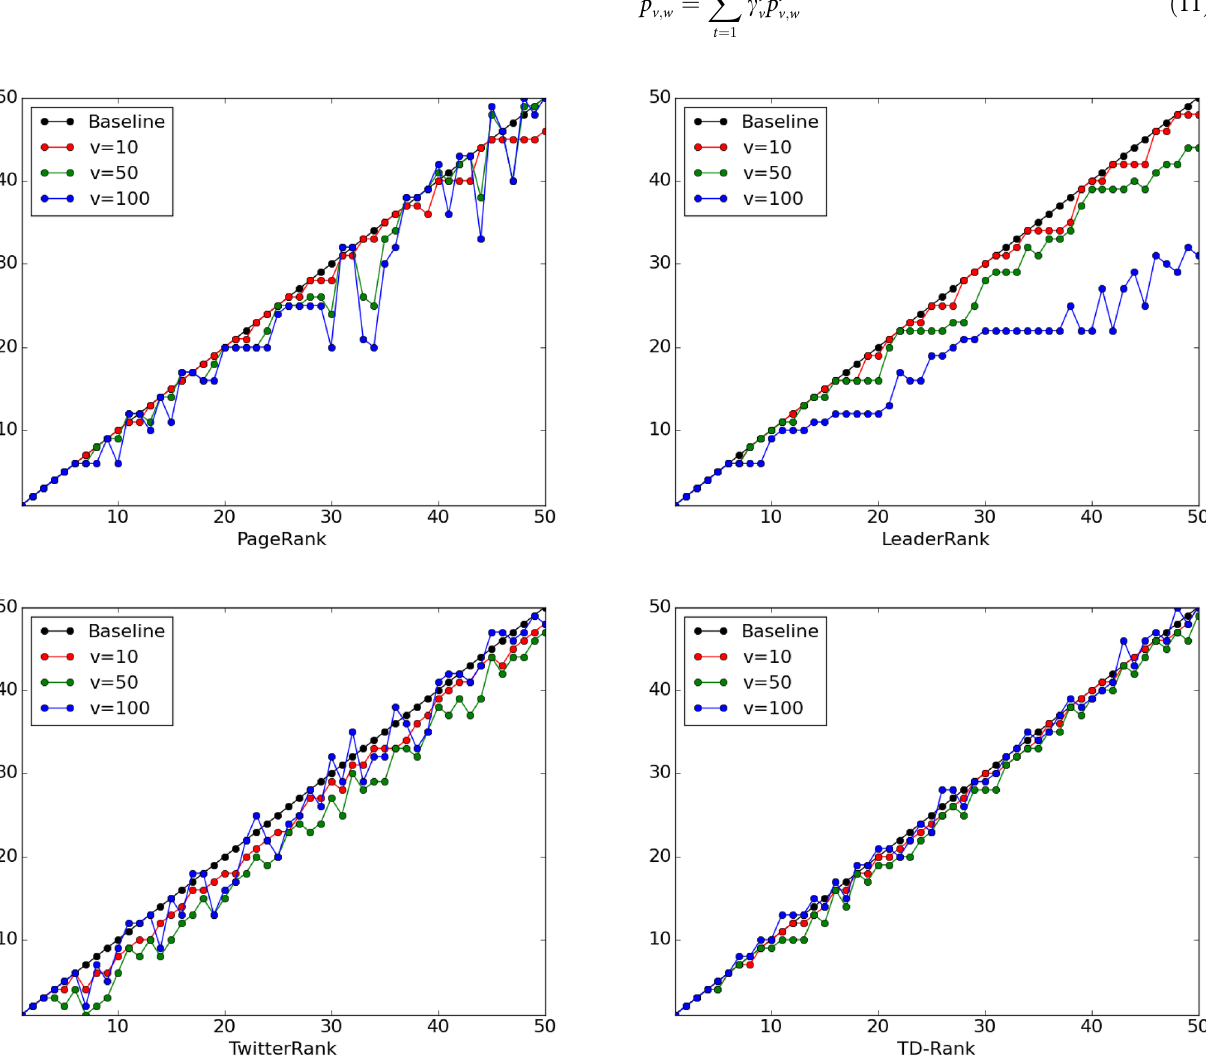
Fig 4. The spammer effect on ranking results. (a) PageRank, (b) LeaderRank (c) TwitterRank, (d) TD-Rank.